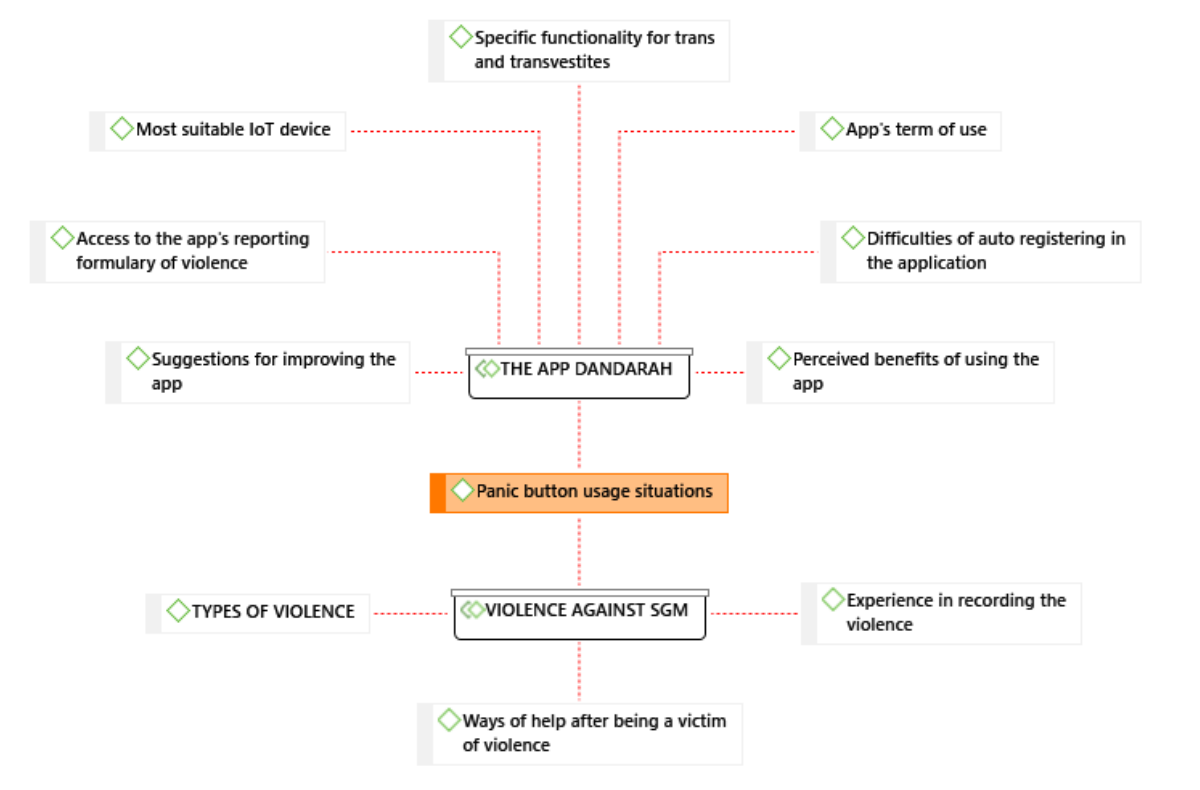
Figure 1. Thematic categories related to the Dandarah App features and violence toward SGM persons.